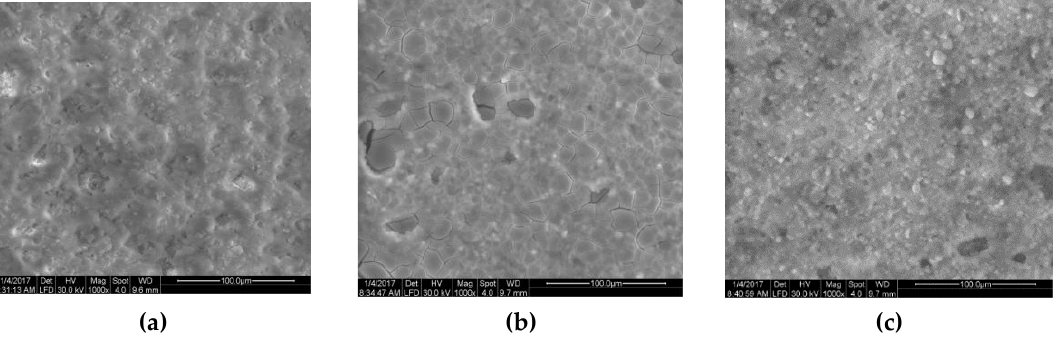
Figure 1. Scanning electron microscope (SEM) images of ( a ) original cordierite, ( b ) cordierite (after pre-treatment), and ( c ) 7.5 wt% Mn/cordierite catalyst.